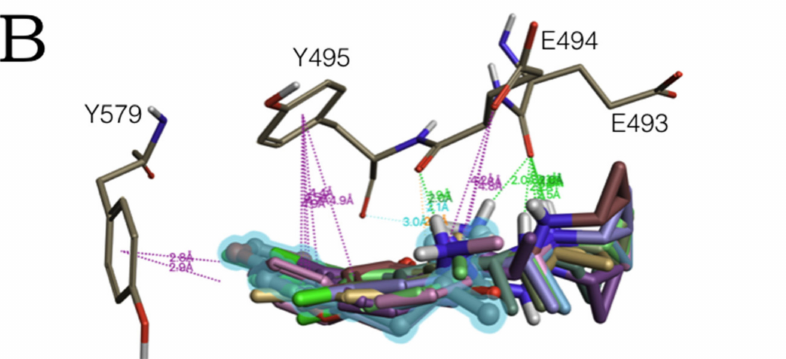
Figure 9. ( A ) 5-HT releasing compounds selected to test the MDMA/hSERT allosteric model. ( B ) Binding of these molecules to the allosteric site of the hSERT model in the ‘5-HT-like orien- tation’ of MDMA (highlighted in blue). Dotted lines represent intermolecular bonds associated to their distances. H-bonds are in cyan and a stronger H-bond in green. Salt bridges and π - π interactions are in purple. Table 1. Gibbs free energies of compounds in Figure 9A on the allosteric site of the MDMA/hSERT models. 5-HT-Like Orientation Escitalopram